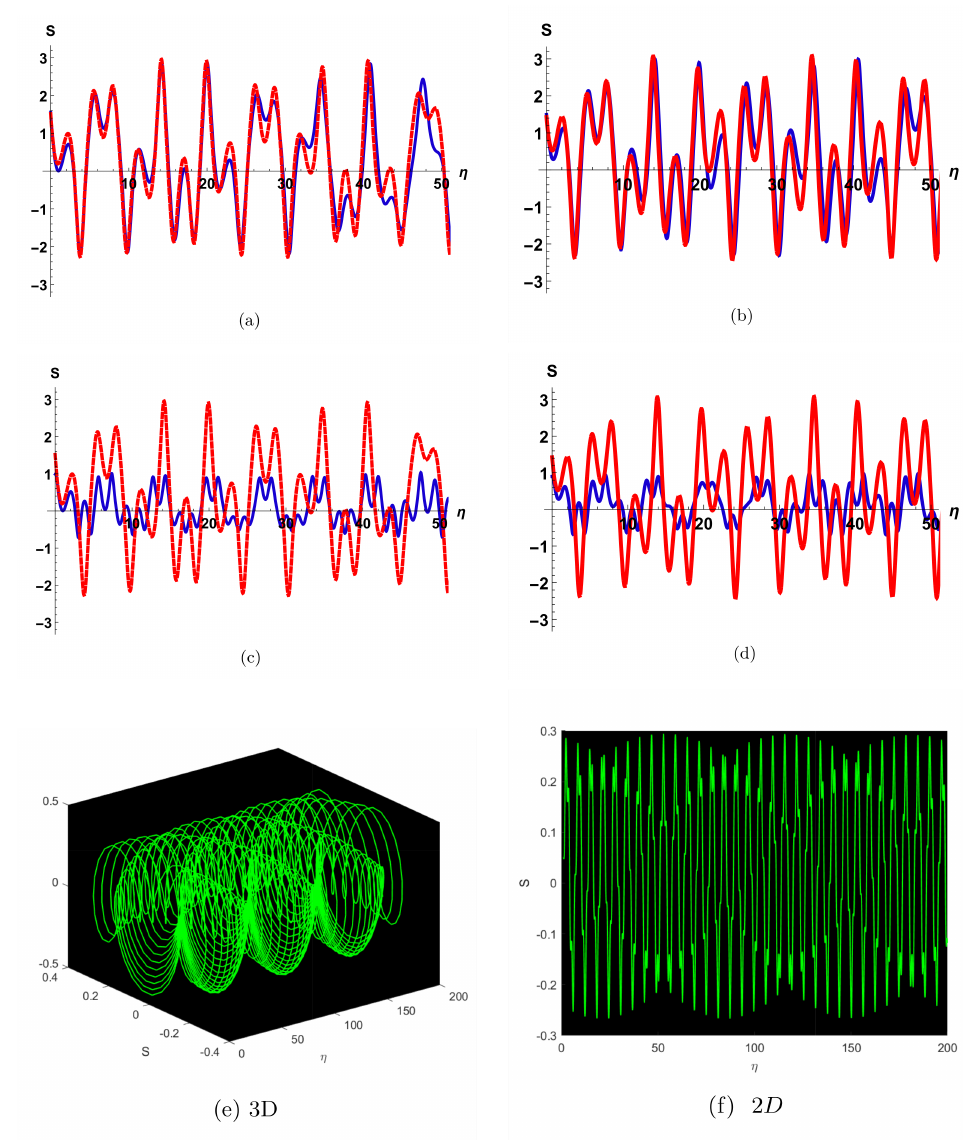
Figure 14. Phase portrait with perturbation term having a 1 = − 1, a 2 = − 1, a 3 = 1, n 0 = 0.93, and f = 4.1 for the dynamical